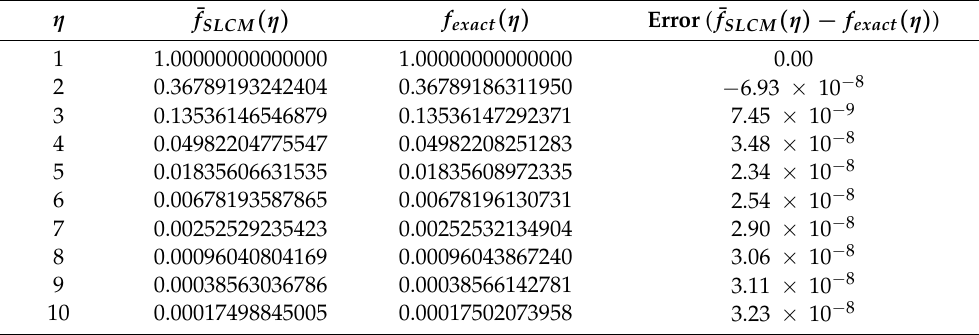
Table 3. Estimations of error for f ( η ) for λ = 1 (suction) by setting S = − 1.0, M = 0.0, φ s 1 = 0.0, φ s 2 = 0.0, Ec = 0.0.